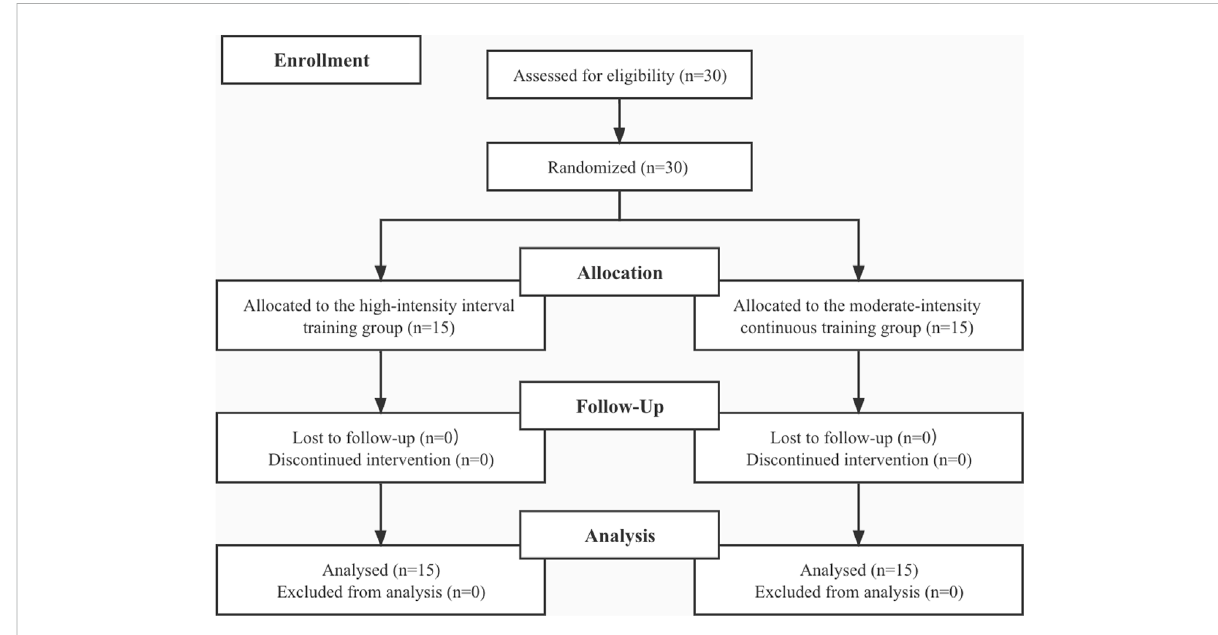
FIGURE 1 Flow chart of the progress through the phases of the study according to the CONSORT